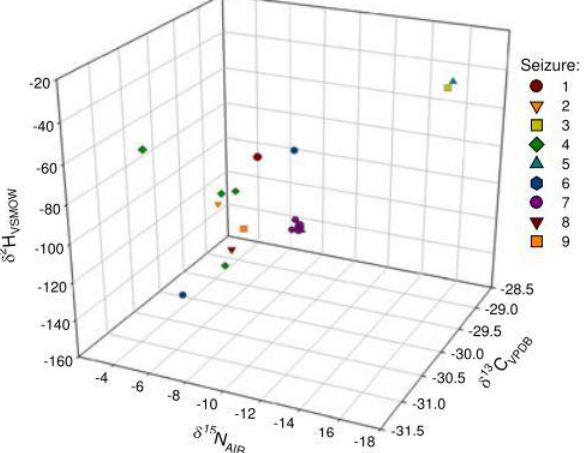
Figure 2. Multivariate representation of δ 13 C, δ 1 5 N, and δ 2 H values of target seized cathinones between 2009 and 2014 [20]. “Reprinted with permission from Ref. [20]. Copyright 2022, John Wiley and Sons ”. Copyright Clearance Center License Number 5366311075145.